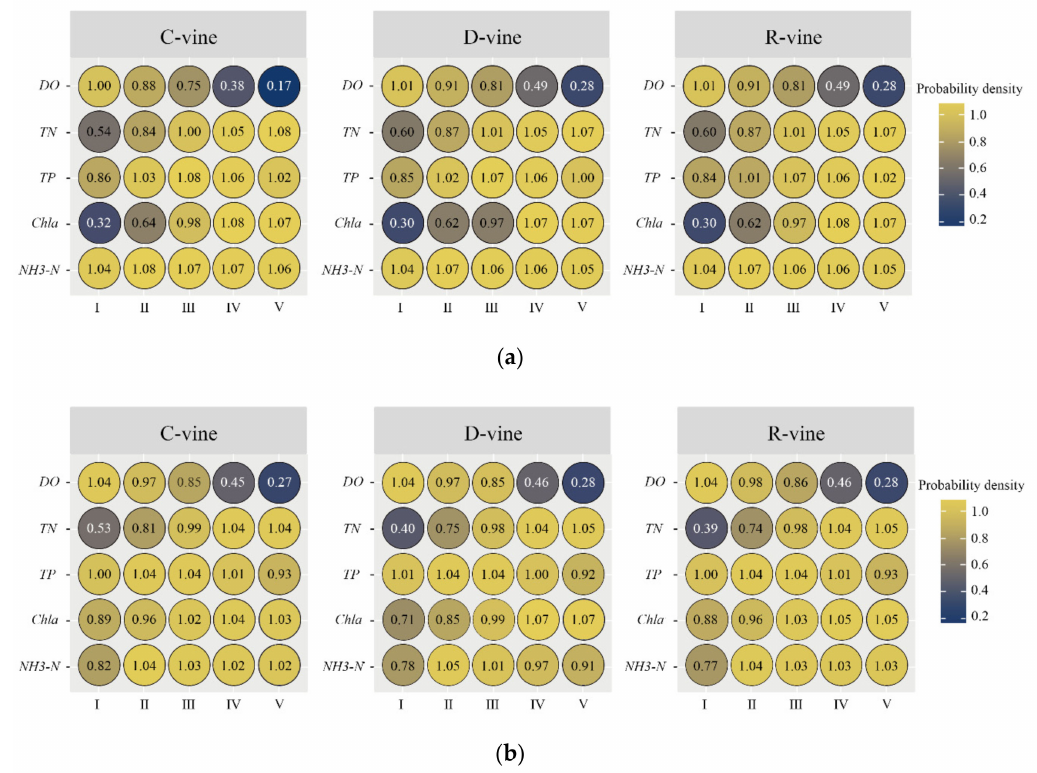
Figure 7. The risk probability density in di ff erent working conditions in the period of B-IRSN ( a ) and A-IRSN ( b ) by using C-, D-, and R-vine, respectively. When the indicators are in the same standard limits, the higher the probability density of a certain variable, the greater the impact on joint water pollution risk. The roman numbers represent the risk probability